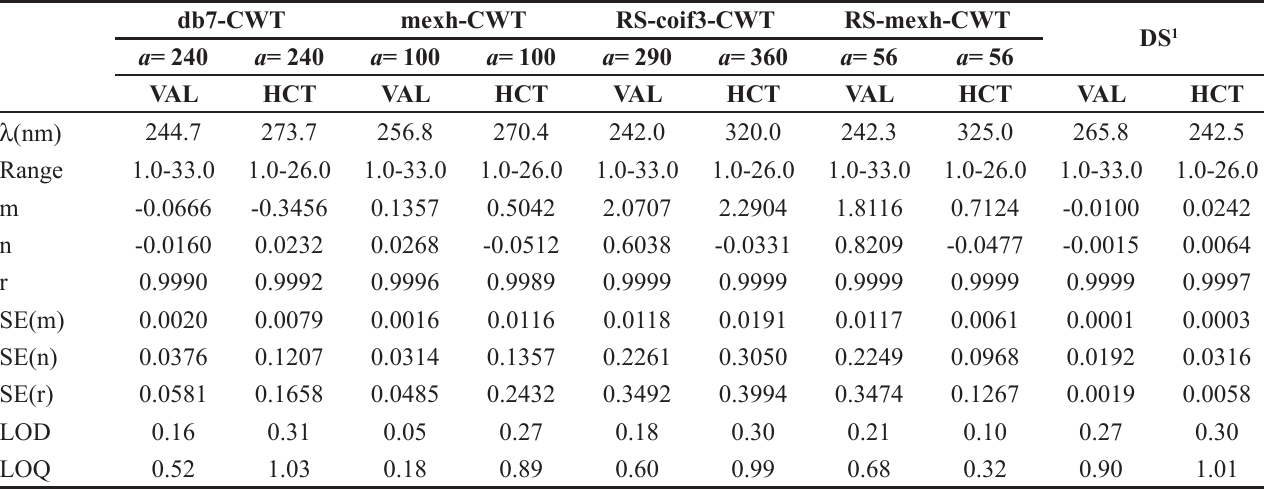
TABLE I - Linear least square analysis and statistical results